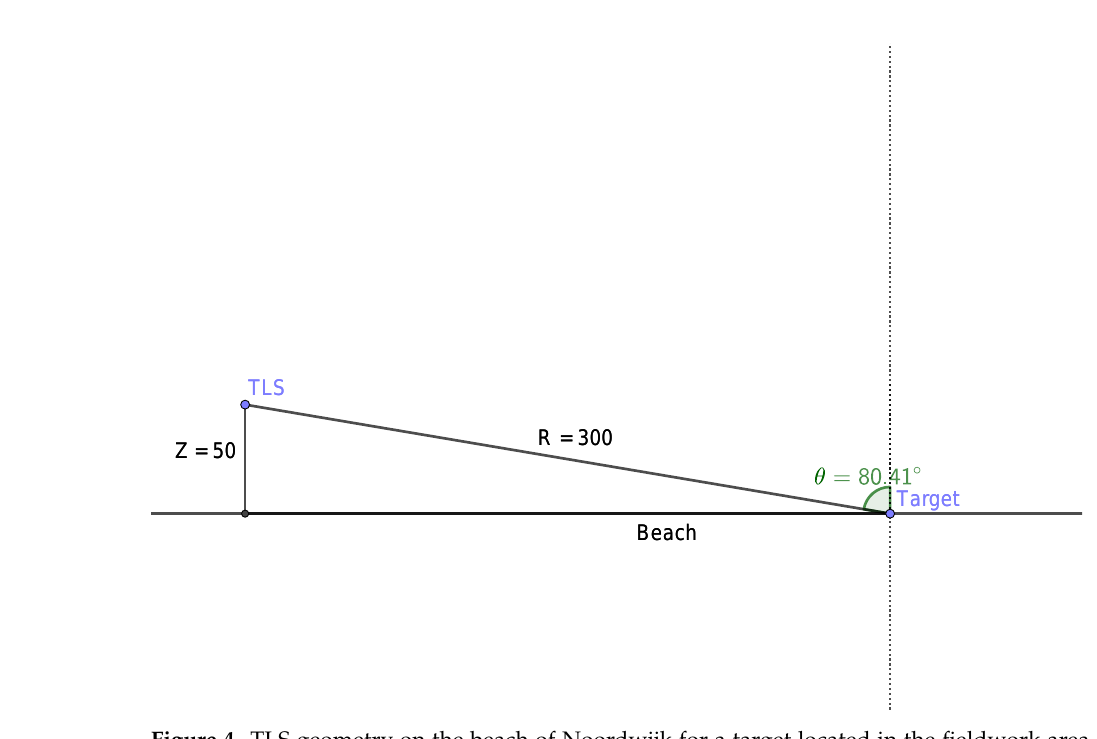
Figure 4. TLS geometry on the beach of Noordwijk for a target located in the fieldwork area (A). Similar values occurred for other areas located in the TLS’s field of view (e.g., area